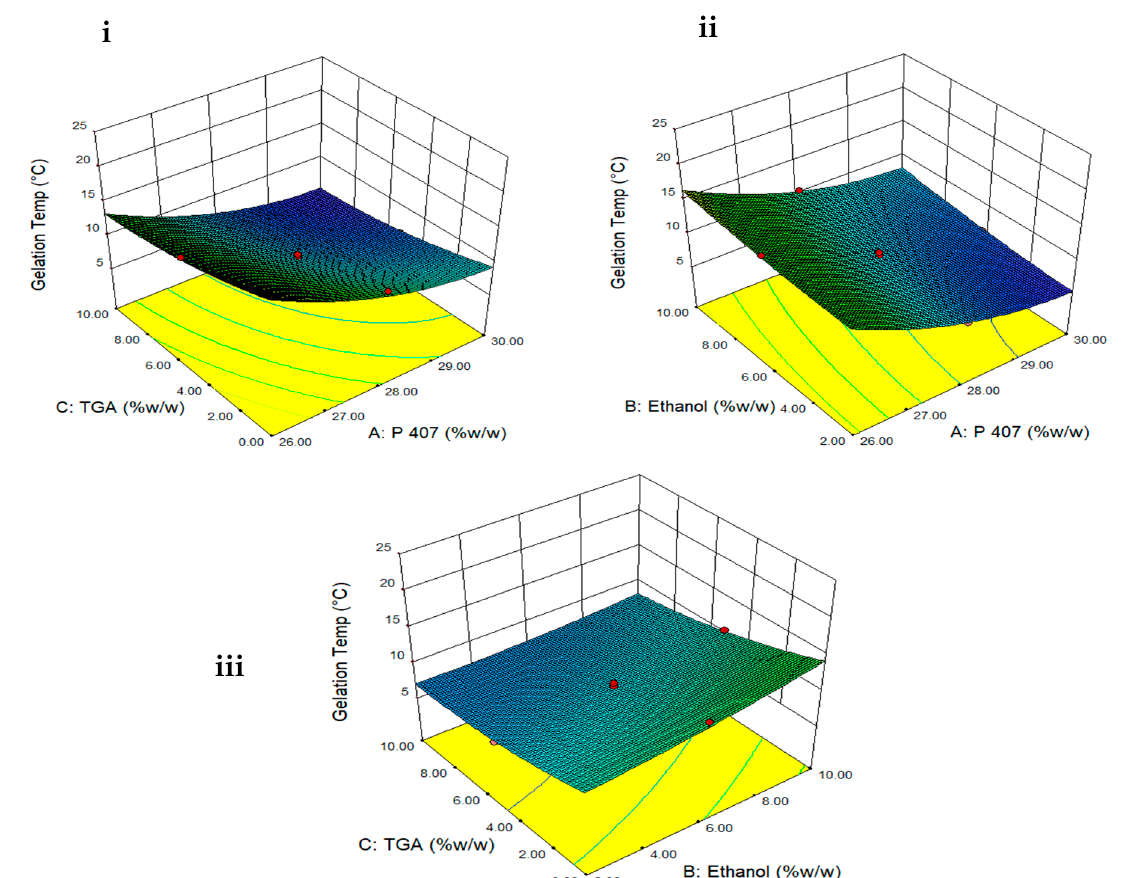
Figure 2. Three-dimensional surface plots showing effect of ( i ) TGA and P407 concentration on gelation temperature when ethanol is constant, ( ii ) ethanol and P407 concentration on gelation temperature when TGA is constant and ( iii ) TGA and ethanol concentration on gelation temperature when P407 is constant.